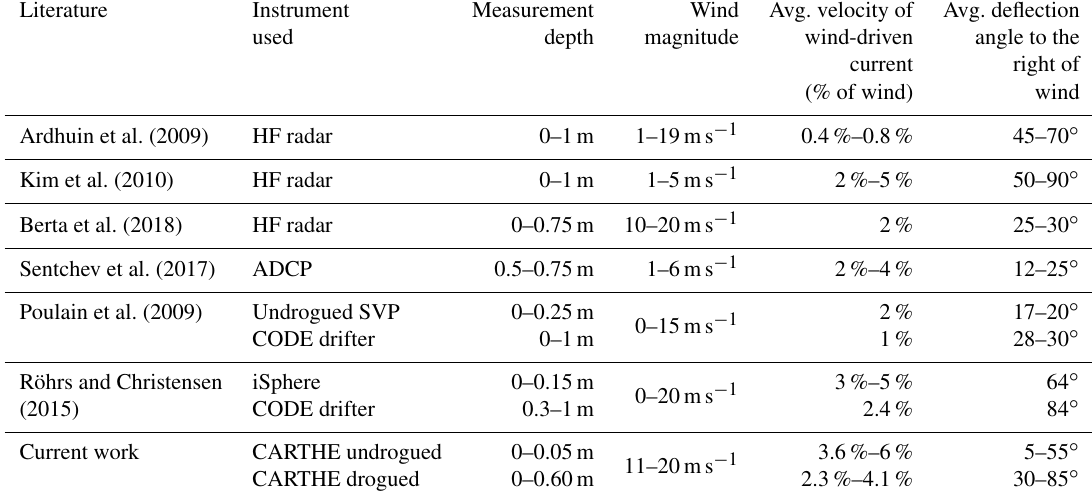
Table 1. Review of literature on wind-driven surface currents using real ocean, observational data.